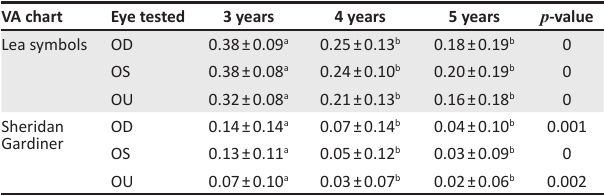
TABLE 1: Comparing the mean visual acuity scores (in logMAR) across the three different age groups using both charts. VA chart Eye tested